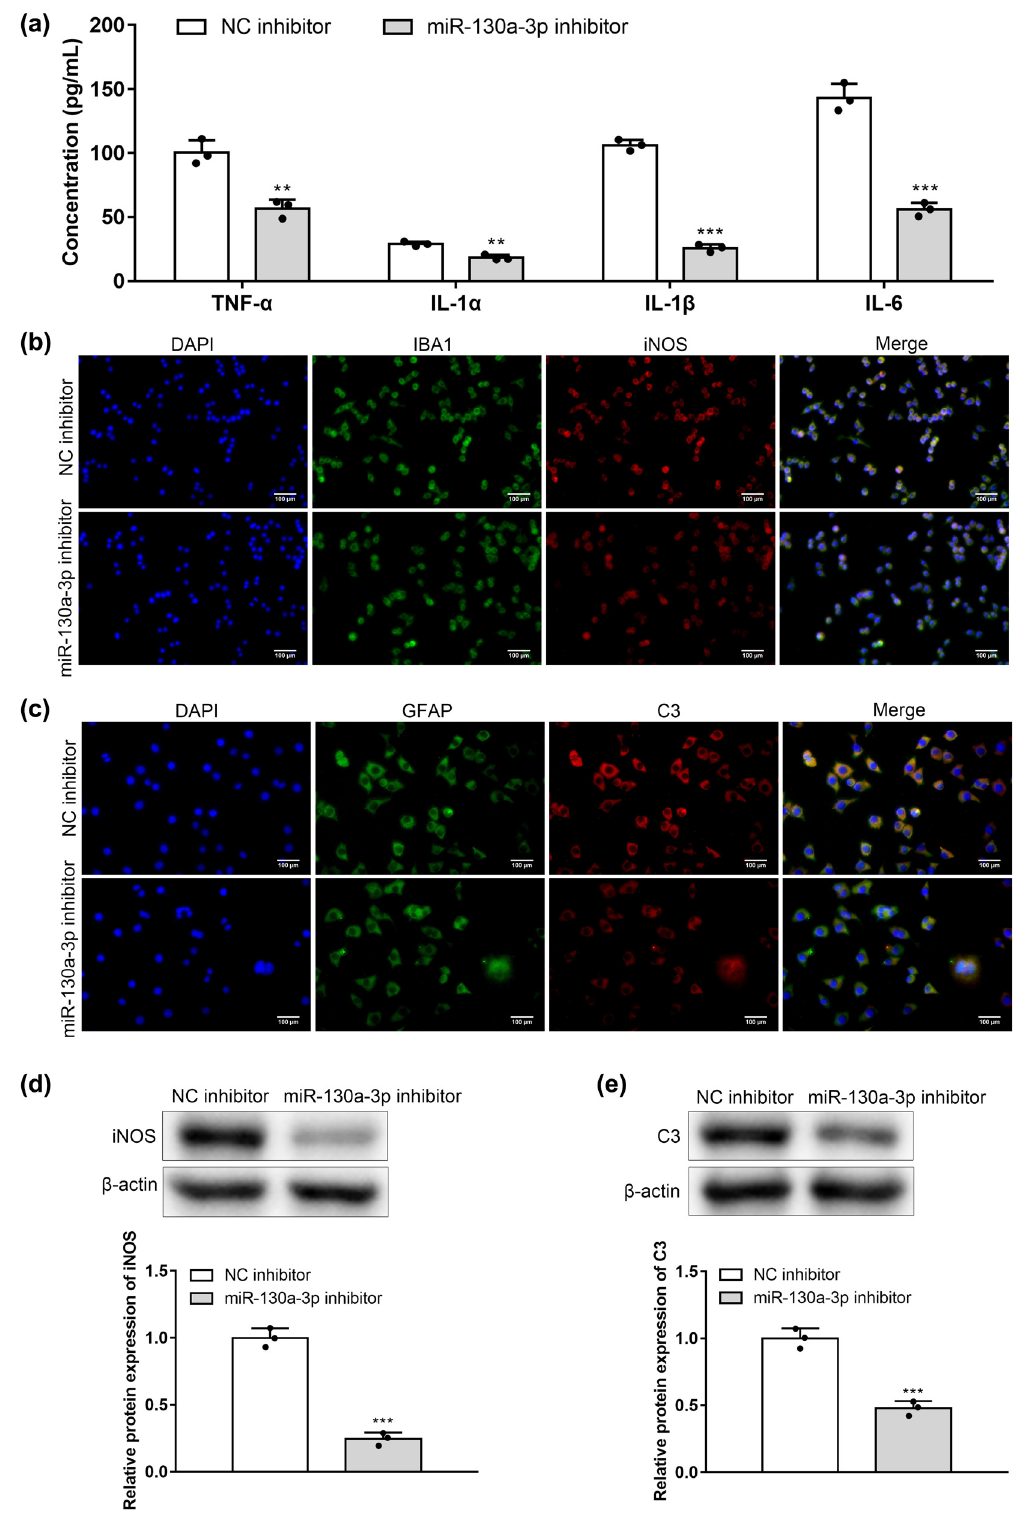
Figure 4: miR - 130a - 3p de fi ciency inactivated the astrocytes and microglial cells. ( a ) Concentrations of IL - 1 α , IL - 1 β , TNF - α , and IL - 6 in supernatants of microglial cells with miR - 130a - 3p inhibitor were assessed by ELISA. ( b ) Immuno fl uorescence staining of IBA1 and iNOS in microglial cells with miR - 130a - 3p inhibitor. ( c ) Immuno fl uorescence staining of GFAP and C3 in astrocytes with miR - 130a - 3p inhibitor. ( d ) Western blotting of iNOS protein in microglial cells. ( e ) C3 protein in astrocytes with miR - 130a - 3p inhibitor. ** P < 0.01, *** P < 0.001 vs NC